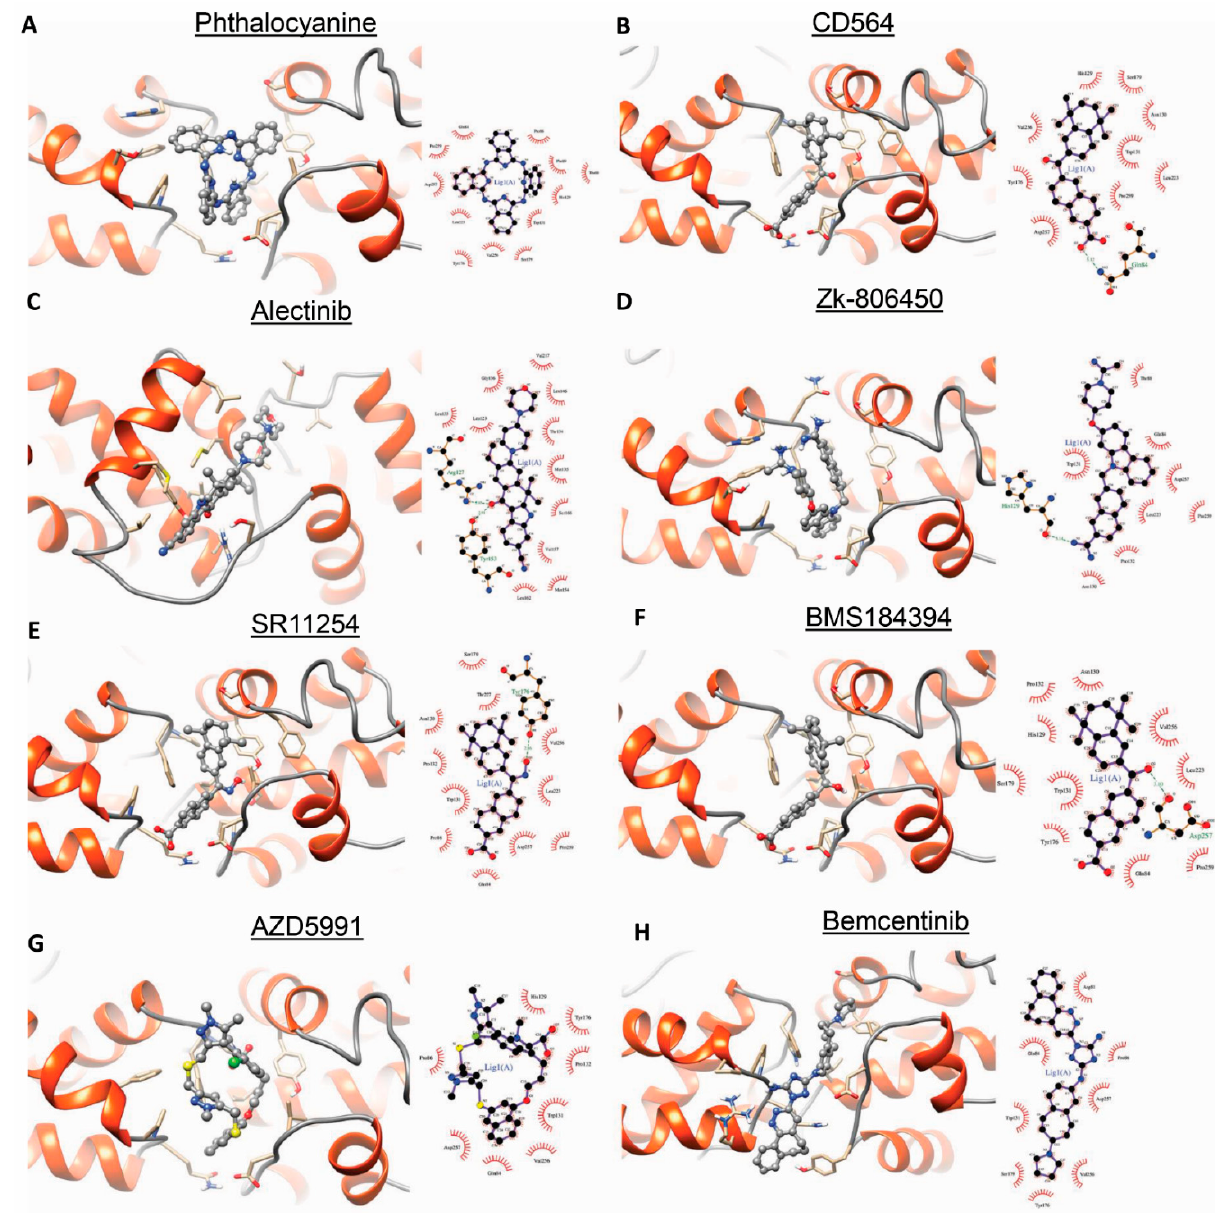
Figure 5. Results of the 8 top-ranking docked compounds with the BRF2 protein according to their binding energies. ( A , B ) surface views of the two best-ranked ligands according to docking. ( C – H ) protein–ligand 3D and 2D interaction diagrams of the protein ligand